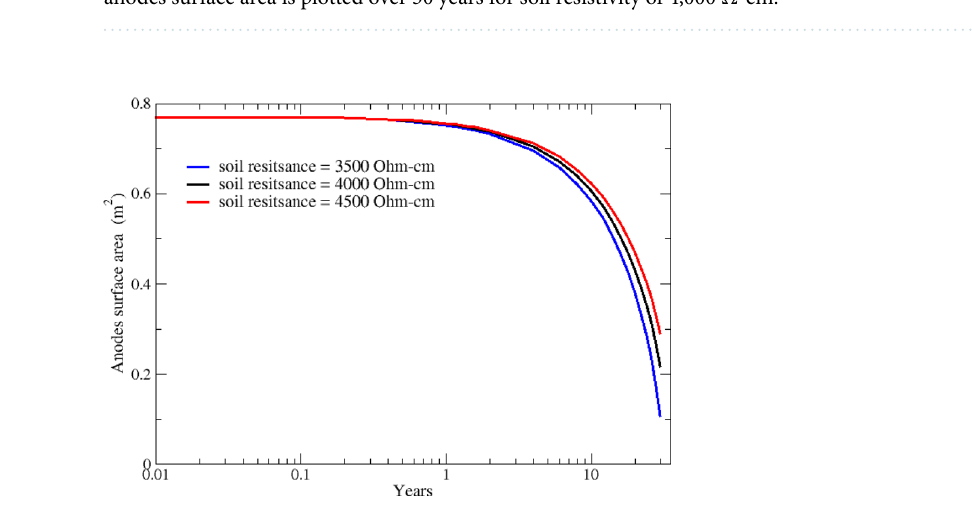
Figure 4. Comparison of surface area reduction for two anodes due to material depletion. Change in the anodes surface area is plotted over 30 years for soil resistivity of 4,000 Ω-cm.